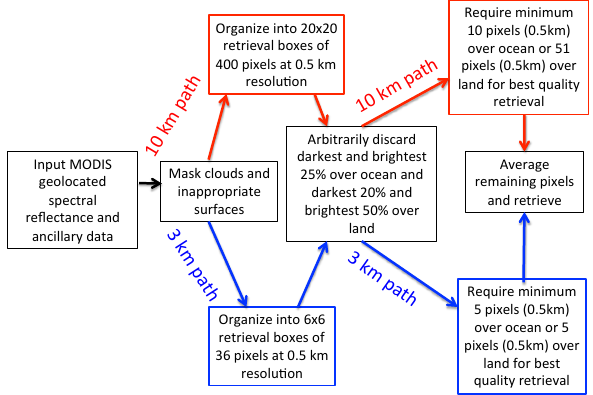
Fig. 2. Flowchart illustrating the different paths of the 10km (red) and 3km (blue) retrievals. The procedures appearing in the black outlined boxes are common to both algorithms.